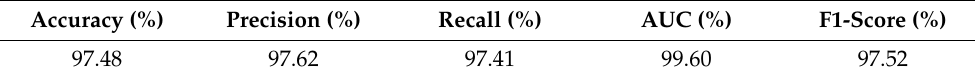
Table 2. Metrics of the classification performed using the selected